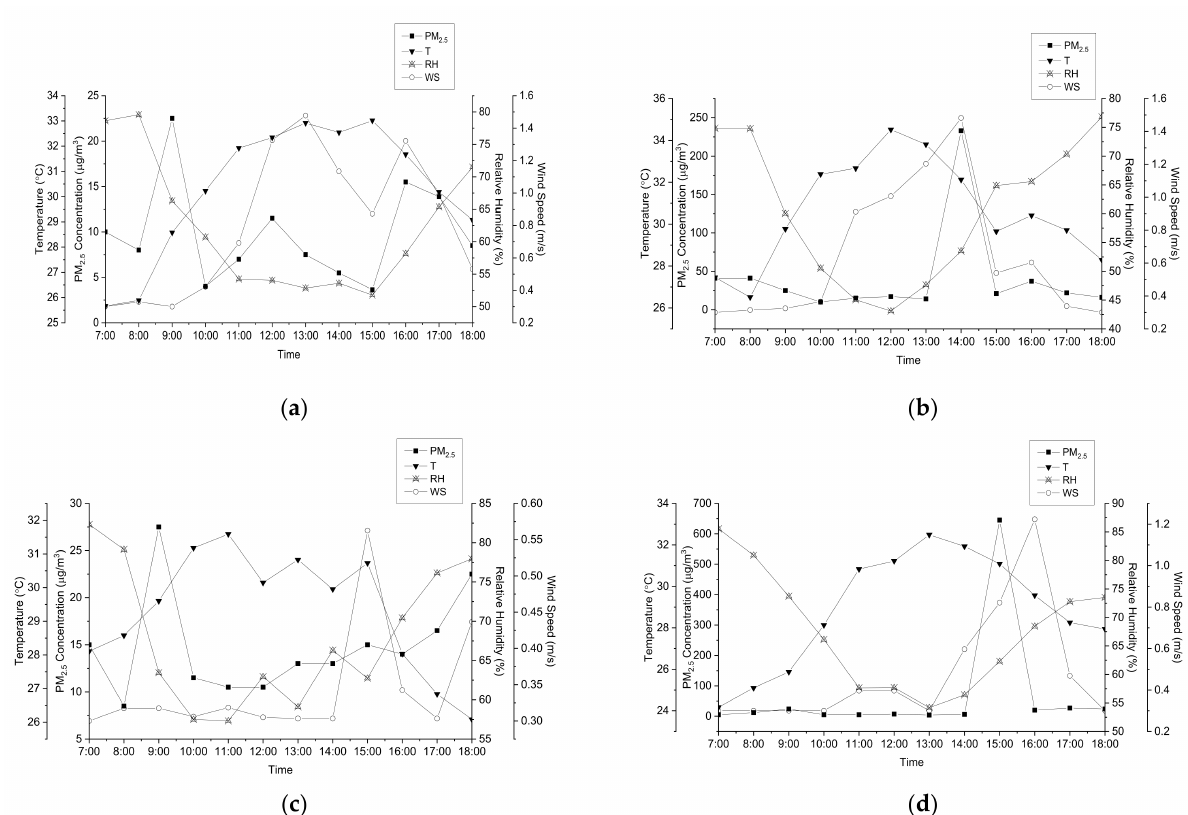
Figure 6. Diurnal plot of PM 2.5 concentration and meteorological parameters at ( a ) S1 (B), ( b ) S1 (BB), ( c ) S2 (B), and ( d ) S2 (BB).